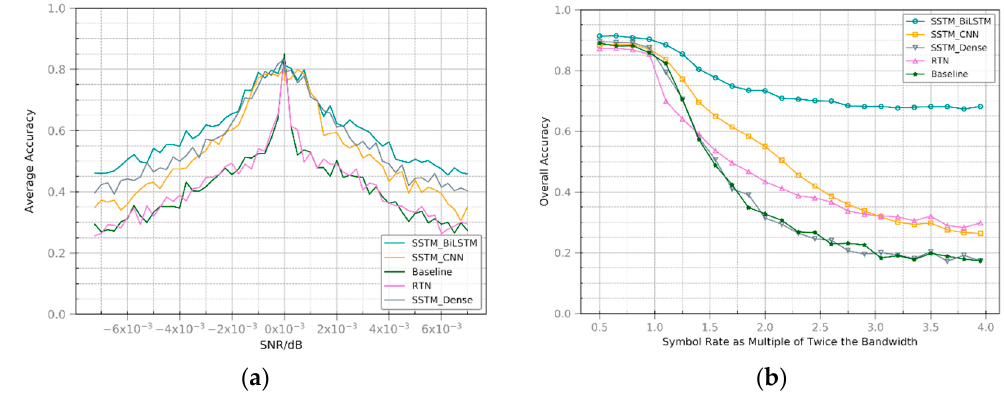
Figure 8. Overall classification accuracy with various offsets in SRO1 and CFO1 scenarios with the aforementioned methods. ( a ) CFO1; ( b ) SRO1.